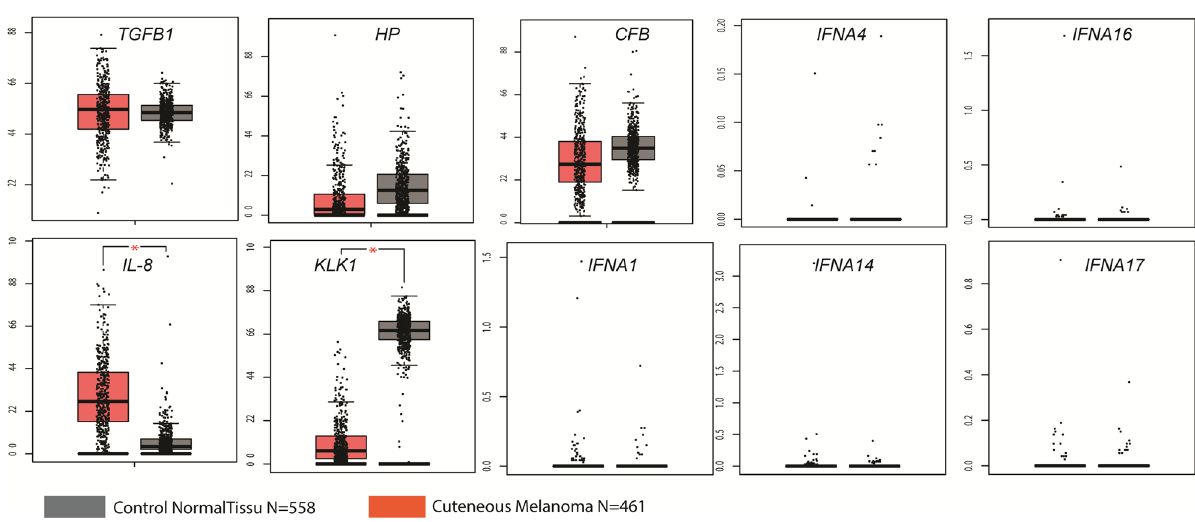
Figure 3. Exploration of 10 commonly expressed inflammatory genes in XP-Mel and SP-Mel via RNA-seq data of sporadic melanoma using GEPIA web server based on the TCGA and GTEx databases. Box plots represent the gene expression level in terms of log2 (TPM) in tumors (red, n = 461) and healthy skin (grey, n = 558) samples, respectively. Healthy skin is matched TCGA adjacent tissue and GTEx data. The method for differential analysis is one-way ANOVA (* p -value <